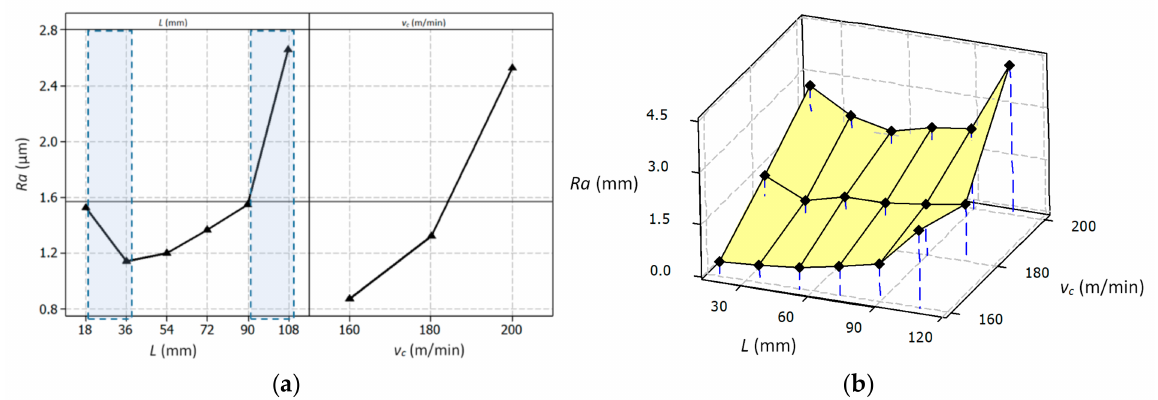
Figure 17. Graphic representation of the influence of particular variables on the mean value of the Ra parameter, main effect plot ( a ), surface plot ( b